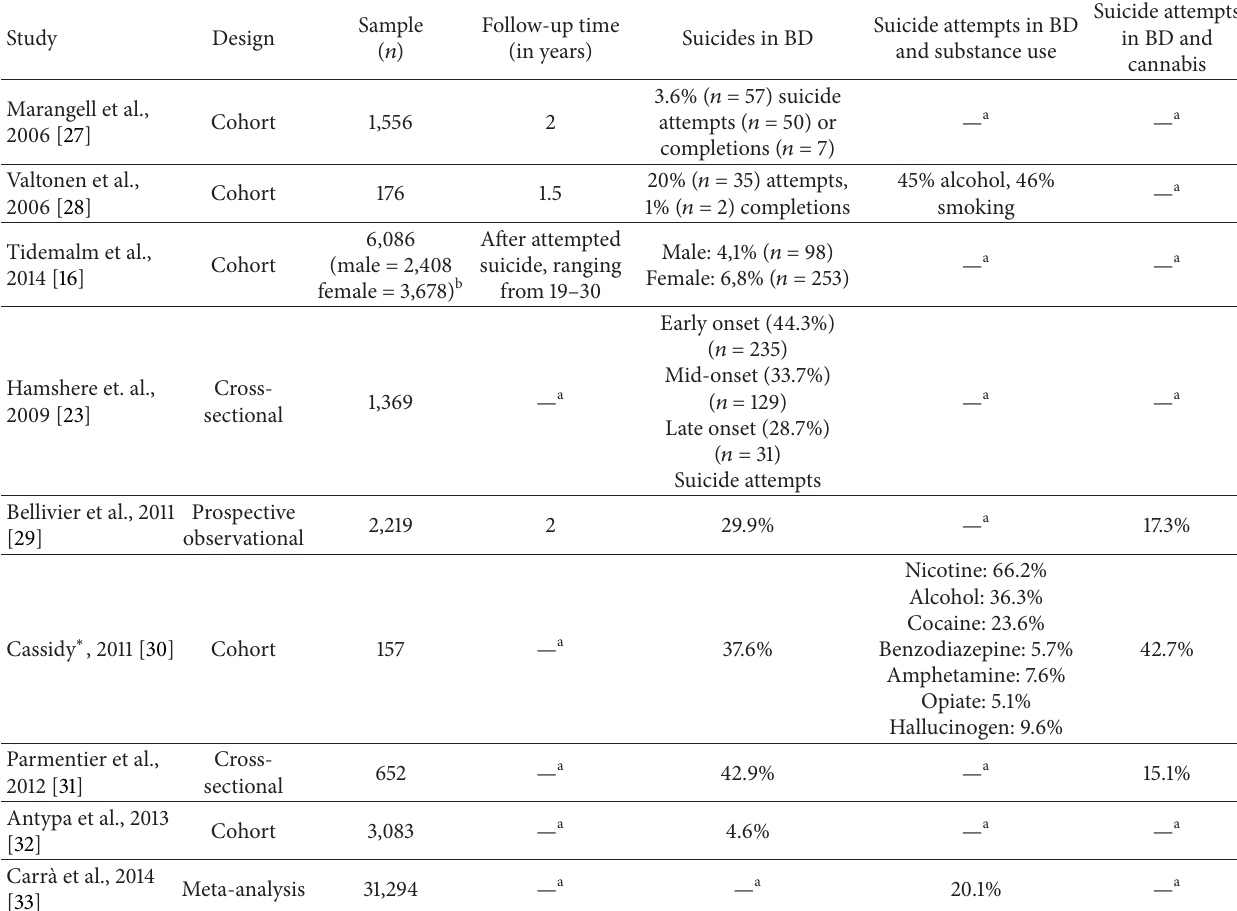
Table 4: Bipolar disorder and suicide